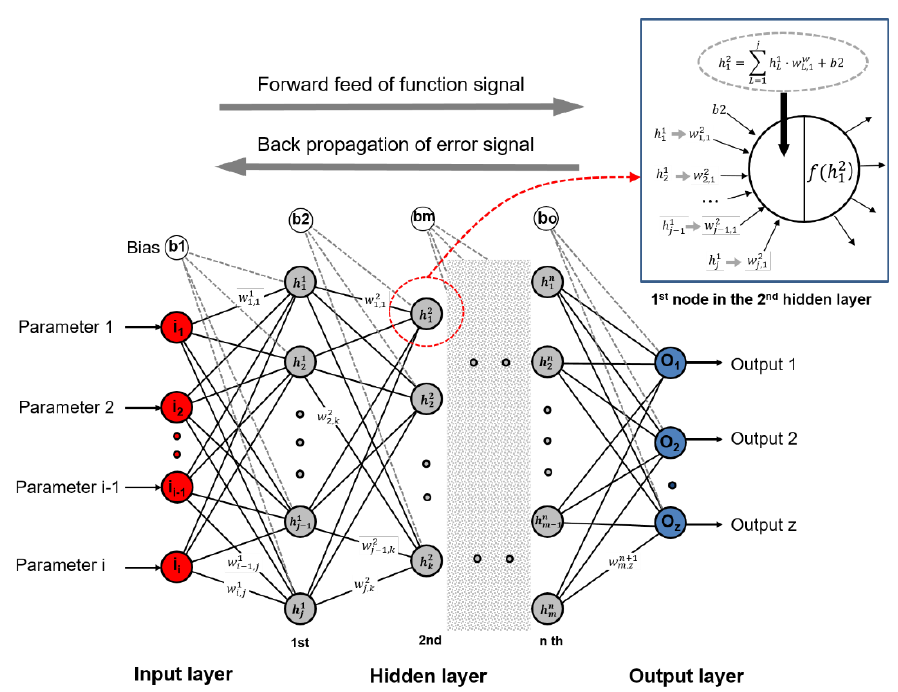
Figure 3. Artificial neural network structure.